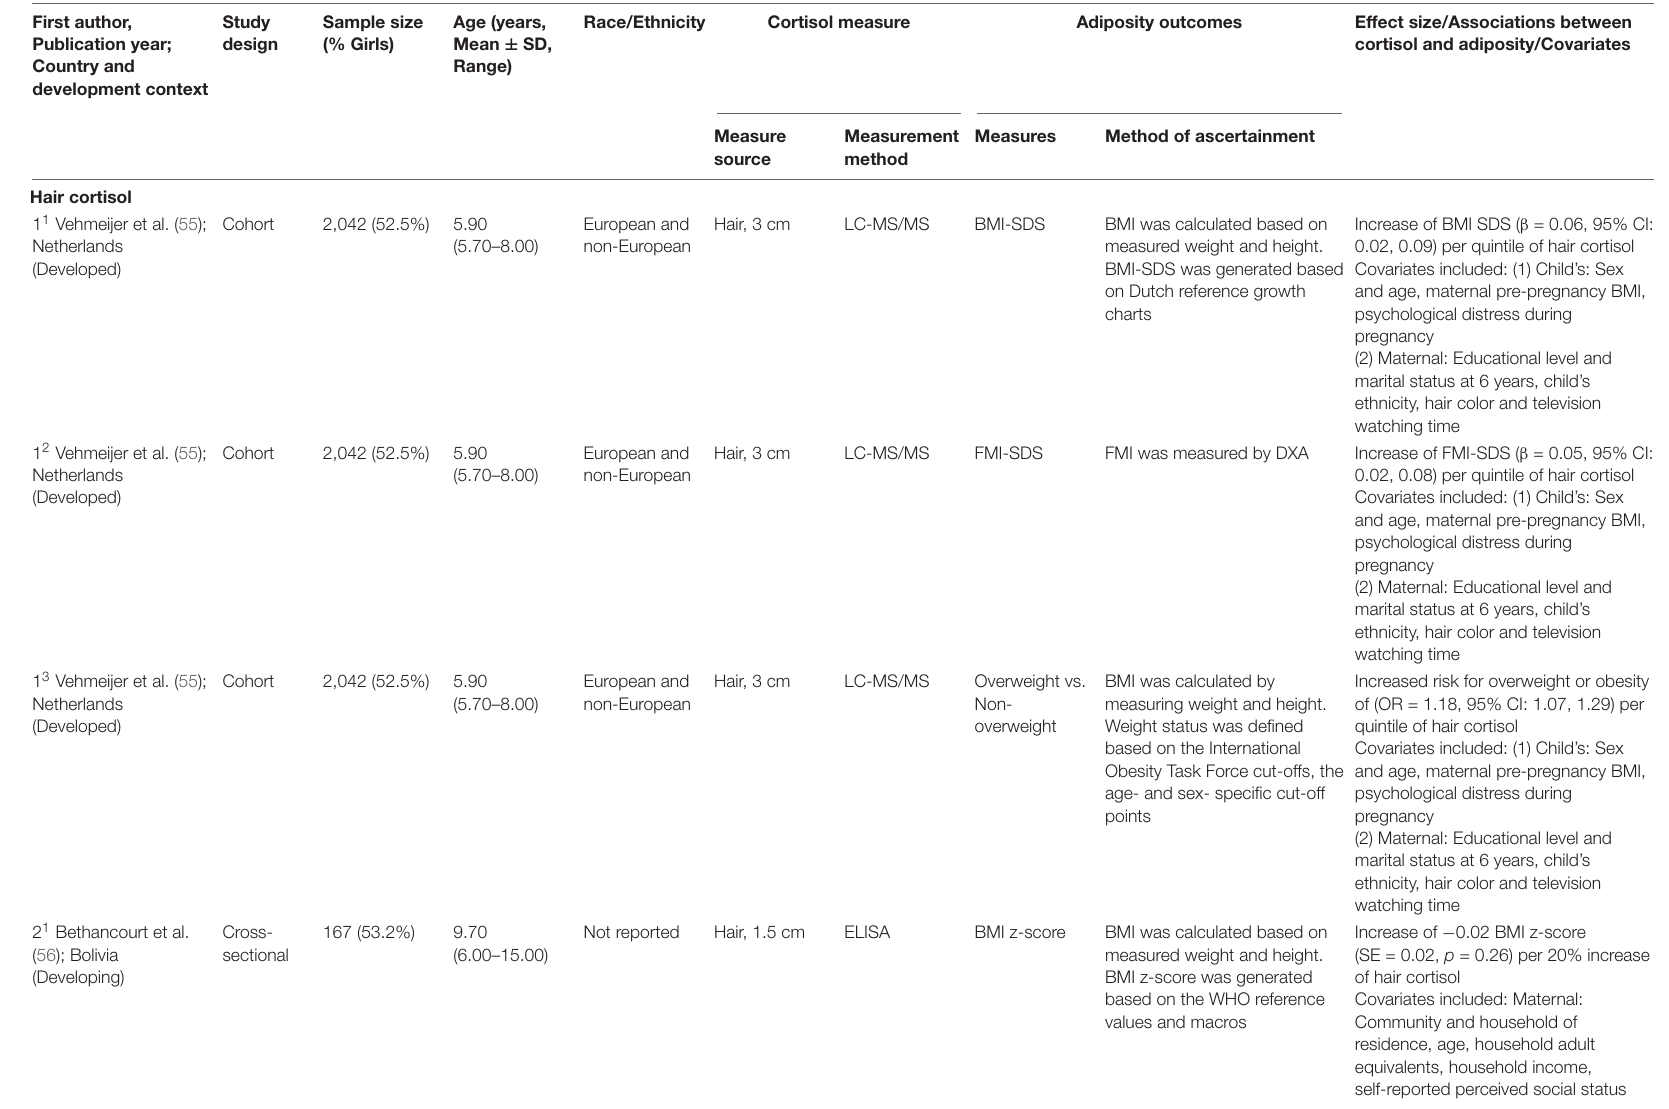
TABLE 1 | Summary of main characteristics of 33 studies reporting on associations between hair, salivary, serum, and/or urinary cortisol concentration with adiposity-related outcomes in